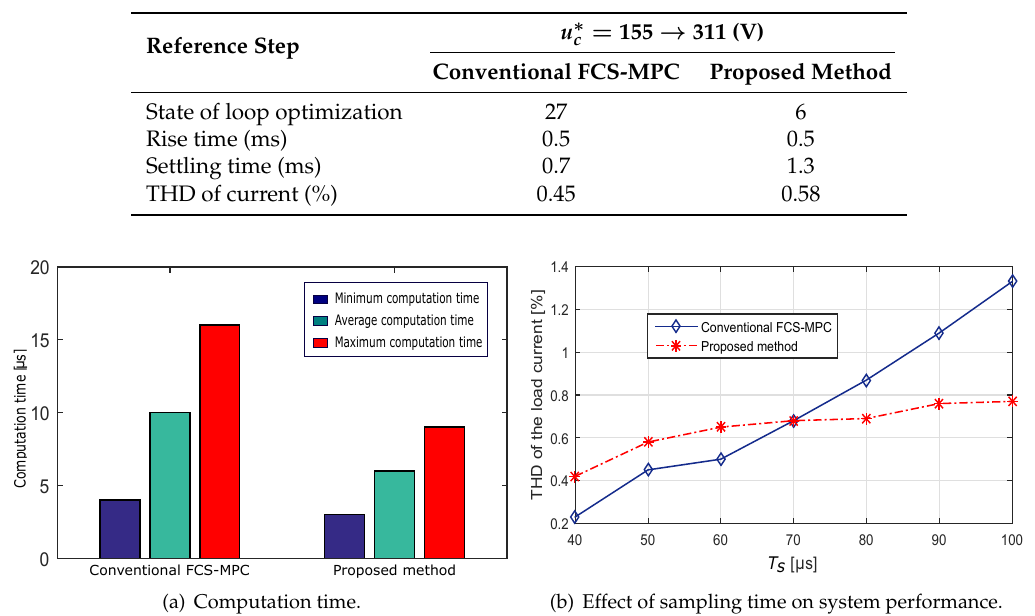
(b) Current harmonic spectrum of the proposed method. Figure 10. The harmonic spectrum of the load current for the conventional FCS-MPC and proposed methods. Table 4. Comparison of transient performance for two controllers.